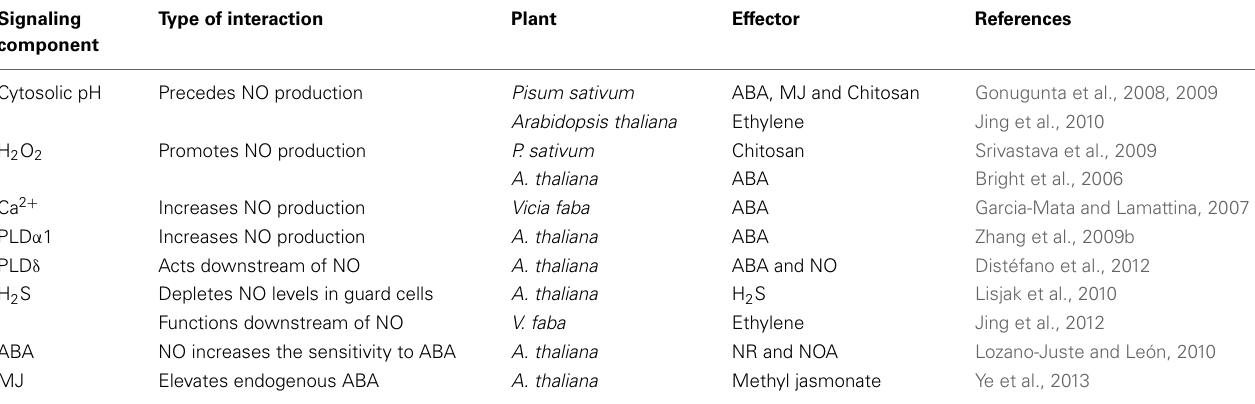
Table 3 | Interactions of signaling components with NO during modulation of stomatal closure induced by different